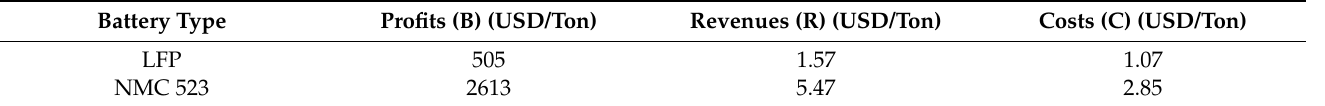
Table 7. The recycling profits of the spent power batteries. Reprinted and edited from IOP Conference Series: Earth and Environmental Science (EES), Vol. 159, Ma et al. [173], The Recycling of Spent Power Battery: Economic Benefits and Policy Suggestions, no. 1, Copyright (2022), distributed under Creative Commons Attribution License.